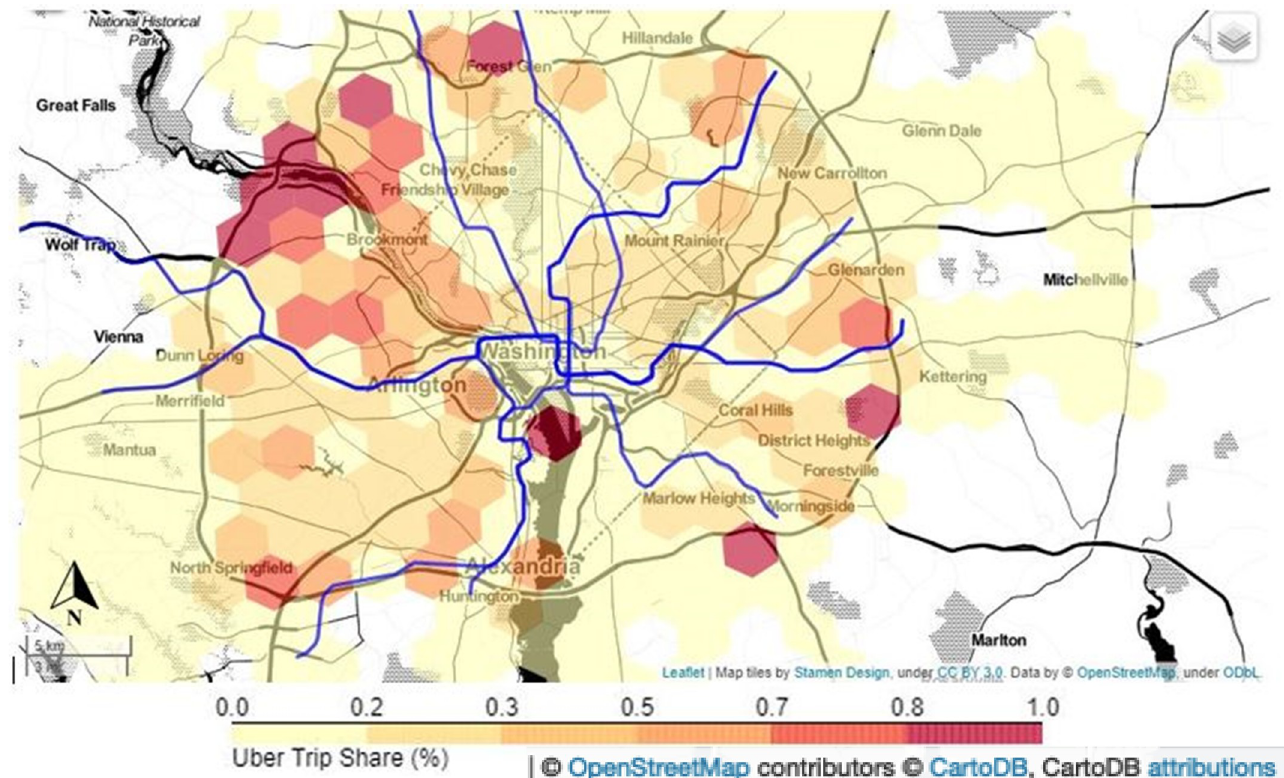
Fig 5. Uber demand share as a percentage of Uber and public transport demand in Washington DC, based on trip origin. Blue lines reflect the different metro lines, and darker red colours indicate a higher Uber demand share.